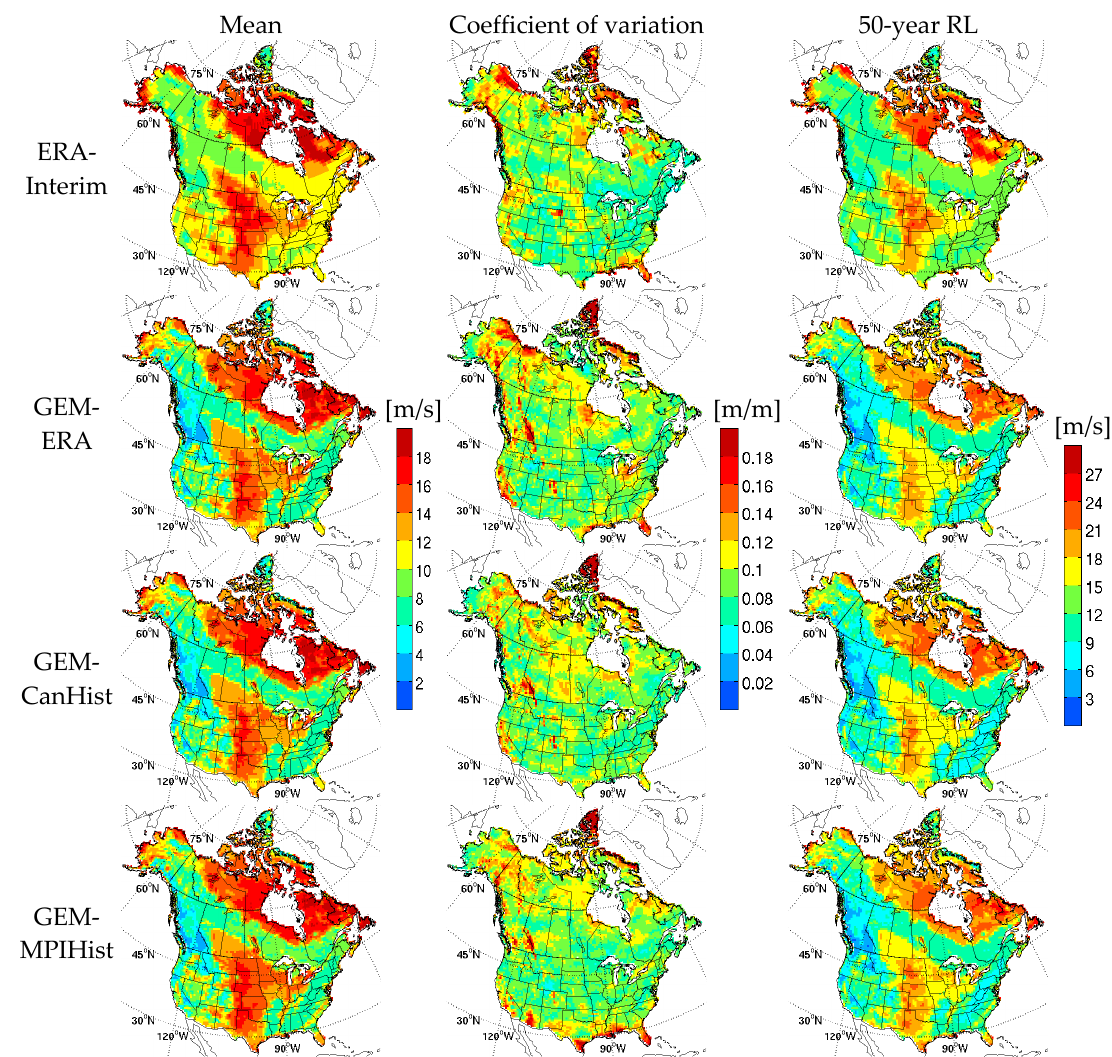
Figure 3. Mean (first column), coefficient of variation (second column), and 50-year return level (RL) (third column) of annual maximum 3-hourly wind speed for ERA-Interim reanalysis and GEM model simulations for the 1981–2010 period.